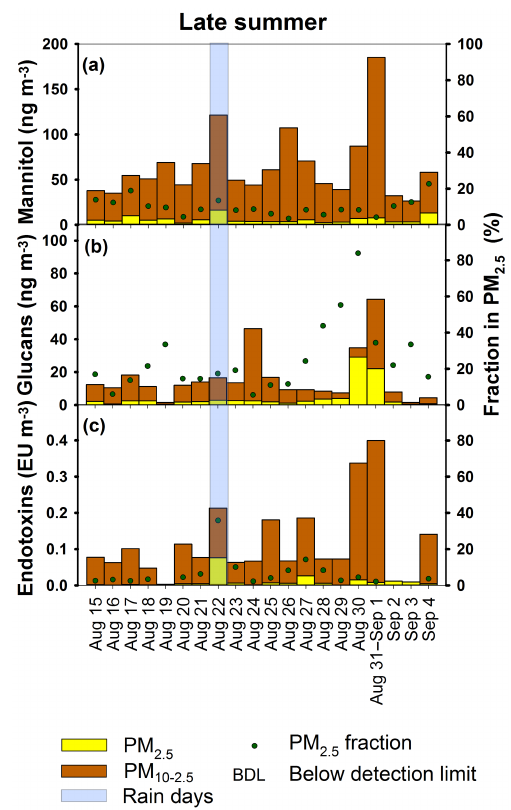
Figure 4. Ambient concentrations of mannitol (a) , glucans (b) , and endotoxins (c) in coarse and fine size fractions in Iowa City, IA, dur- ing late summer of 2013. The percent of PM and bioaerosol tracer mass in fine particles is shown on the right axis for samples in which the analyte was detected in both size modes. Mannitol, the chemical tracer for fungal spores, and endotoxins from Gram-negative bacte- ria in the fine mode increased on 22 August when it